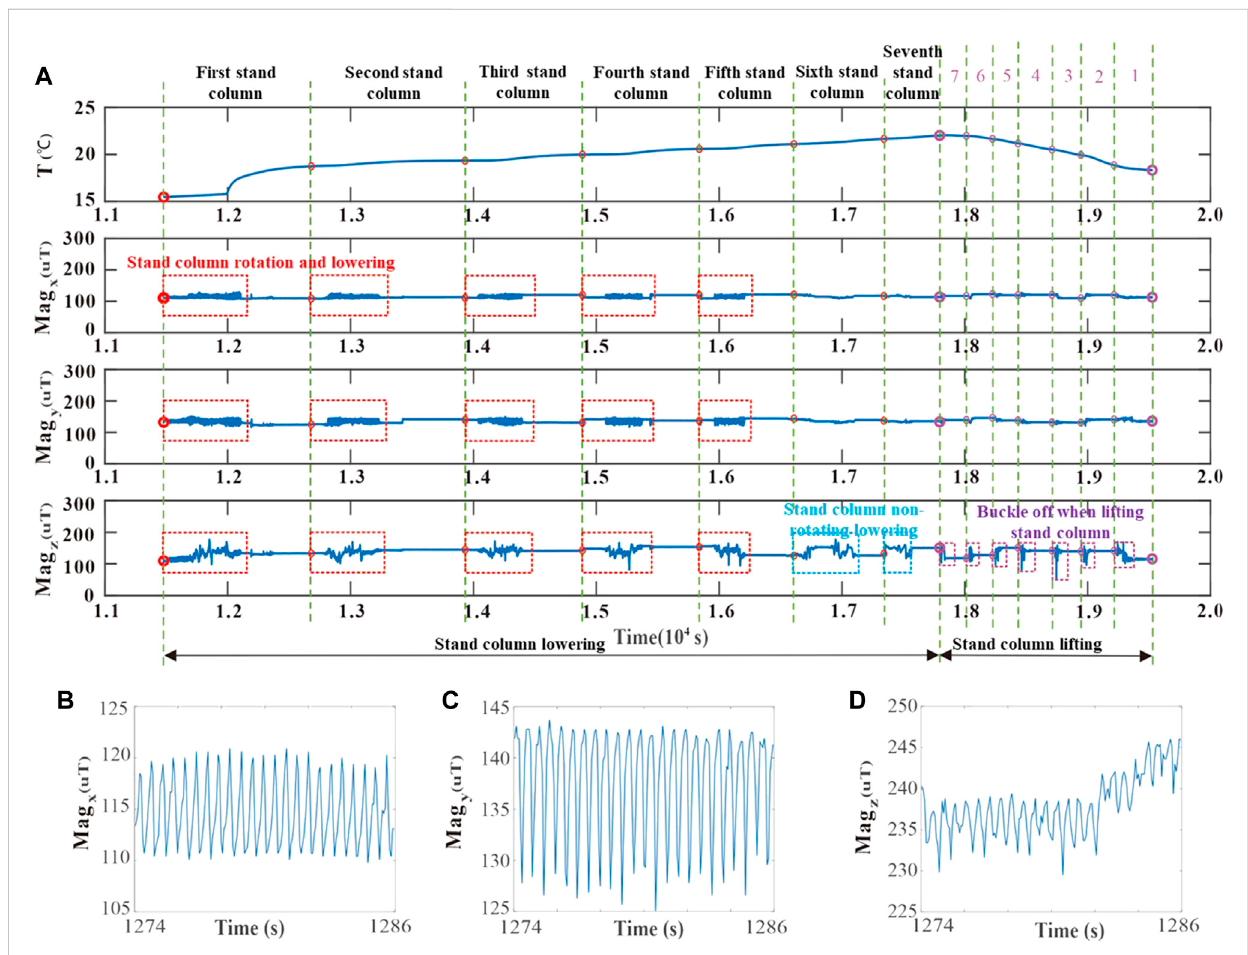
Timeseriesoftemperatureandthree-axismagneticintensities. (A) Timeseriesoftemperatureandthree-axismagneticintensities. (B) Datavariation ofmagnetic fi eldstrengthinX-axiswithtime. (C) Datavariation ofmagnetic fi eldstrengthinY-axiswithtime. (D) Datavariation ofmagnetic fi eldstrength in Z-axis with